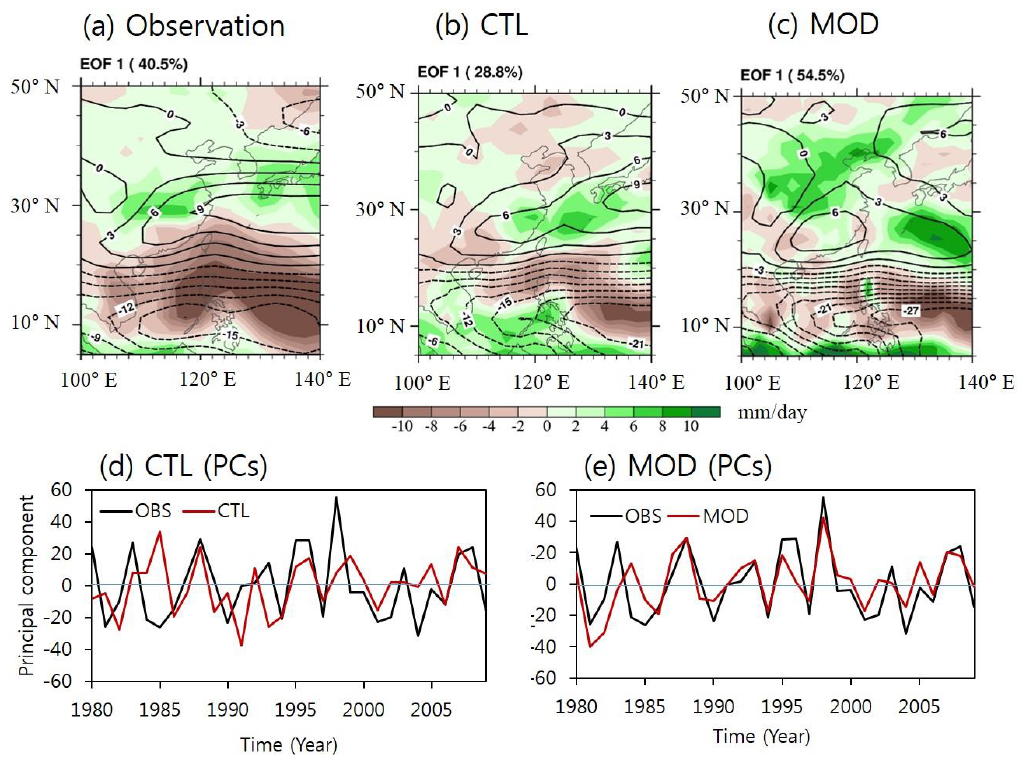
Figure 12. Spatial patterns of first MV-EOF modes of JJA mean precipitation (shadings, mm day − 1 ) and 850-hPa zonal wind (contour, m s − 1 ) from: ( a ) observation; ( b ) CTL; and ( c ) MOD during 30 years (1980–2009). Lower panels represent corresponding principal components from: ( d ) CTL; and ( e ) MOD.